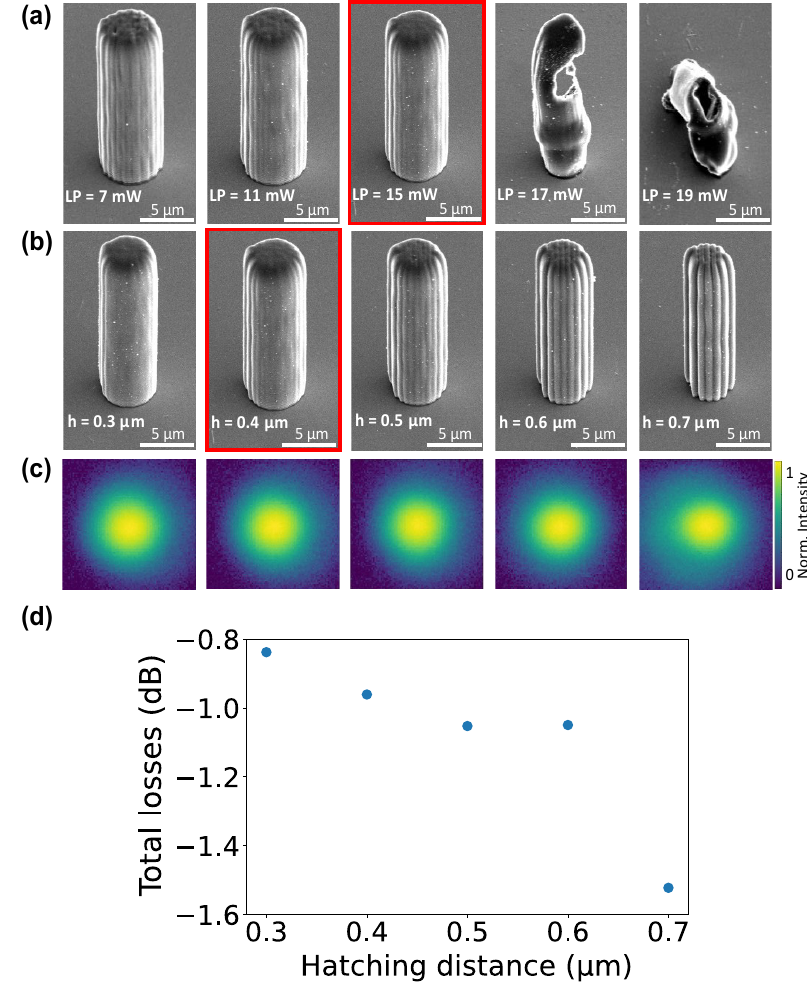
(b). Sample cured with UV light during 20